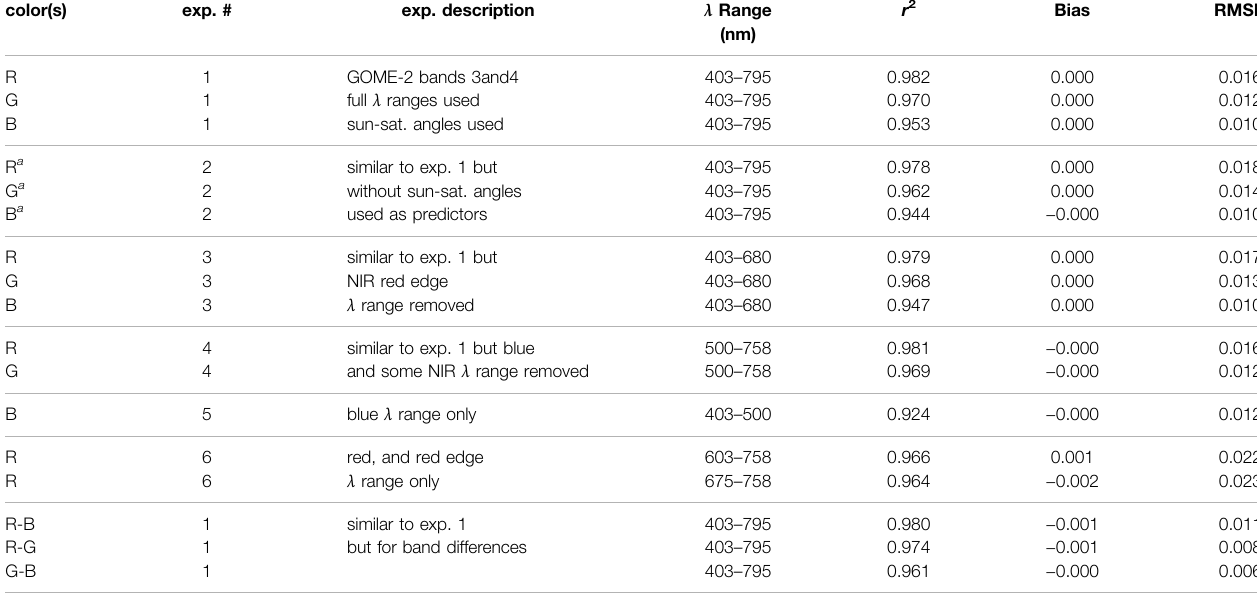
TABLE 1| Statistical comparison of131,544GOME-2 independent(not used intraining) datapoints withcollocated MODISdata fromtraining/evaluationdays listed above. Statisticsincludetherootmeansquareddifference(RMSD),bias(meanofRGB G2 – RGB M ),andvarianceexplained( r 2 ).Thetableissegmentedintodifferentexperiments, denoted by “ exp. # ” . The last grouping is for band